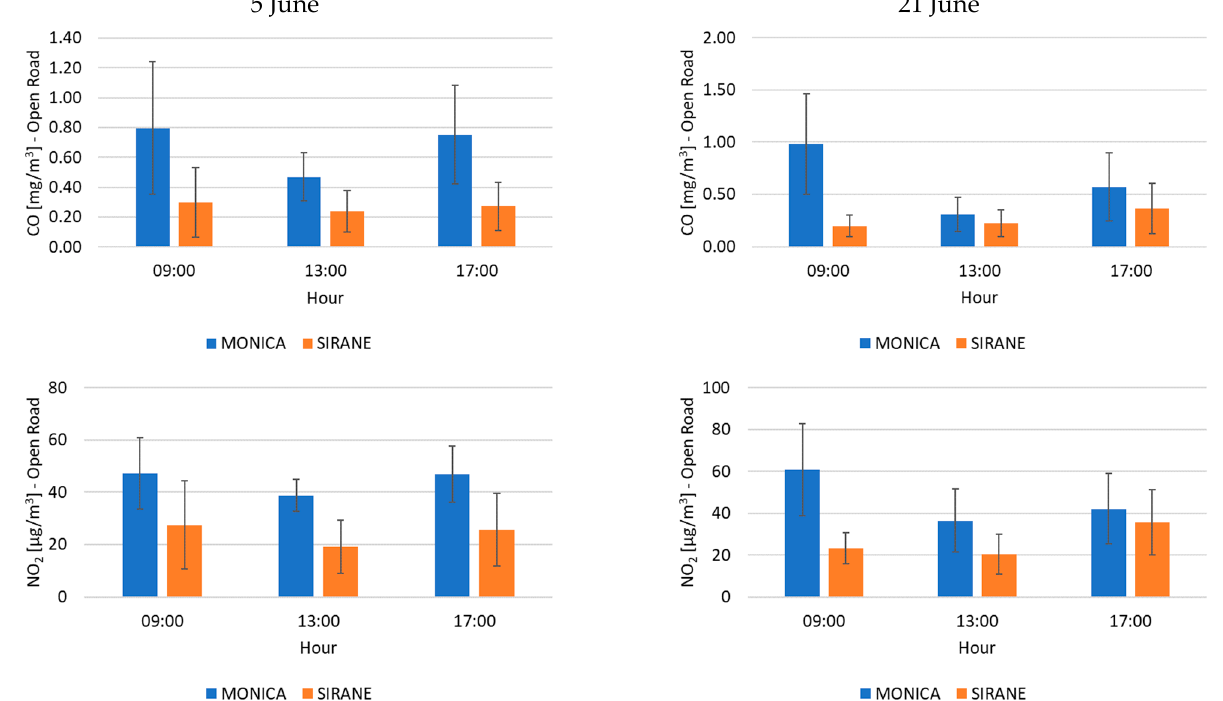
Figure 8. Comparison between the average measured and estimated concentrations of CO and NO 2 pollutants in relation to the open street segments.